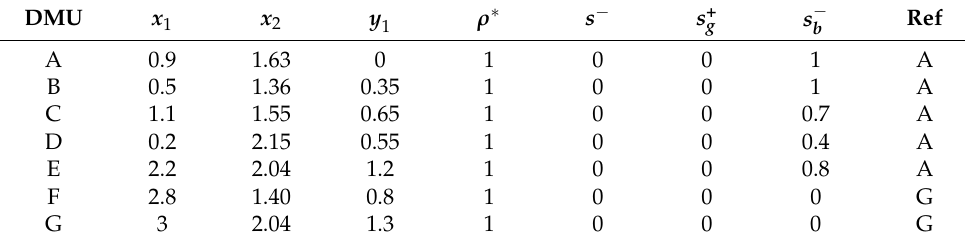
Table 2. The efficiency and the